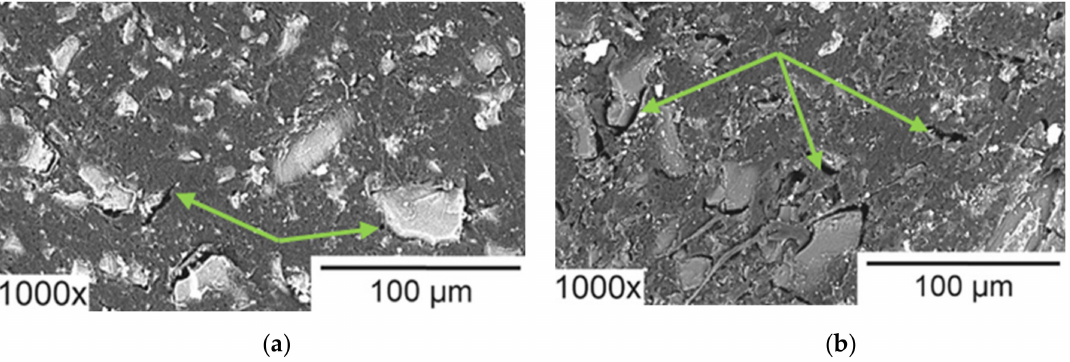
Figure 15. SEM images of heterogeneous ion-exchange membrane IONSEP-HC-A (Iontech, China) be- fore ( a ) and after ( b ) its operation in ED desalination of solution containing 0.116 g/L Na 2 HPO 4 · 7H 2 O, 0.085 g/L NaH 2 PO 4 · 7H 2 O and 5.2 g/L Na 2 SO 4 . Arrows point to cavities between the ion-exchange and inert materials. Reproduced with permission from [162]. Copyright 2022 Elsevier.